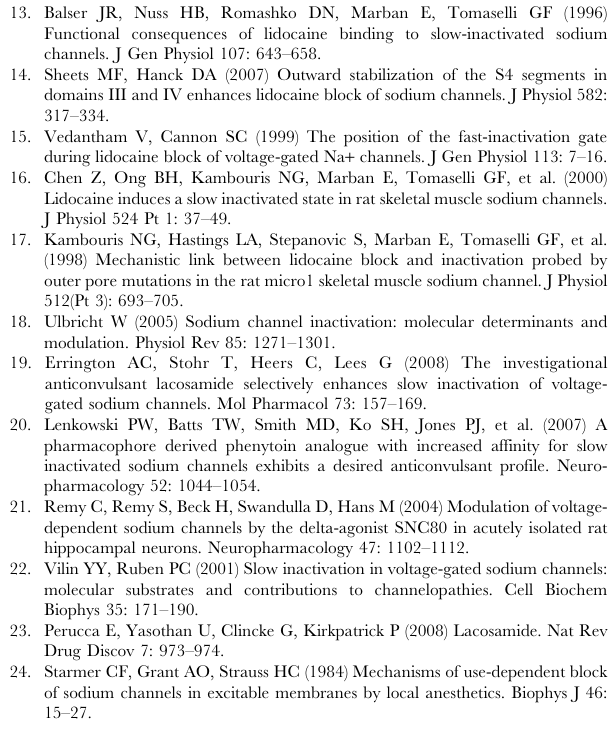
Figure S1 Evaluation of the goodness of fit during optimization of the models Found at: doi:10.1371/journal.pcbi.1000818.s001 (0.39 MB TIF)